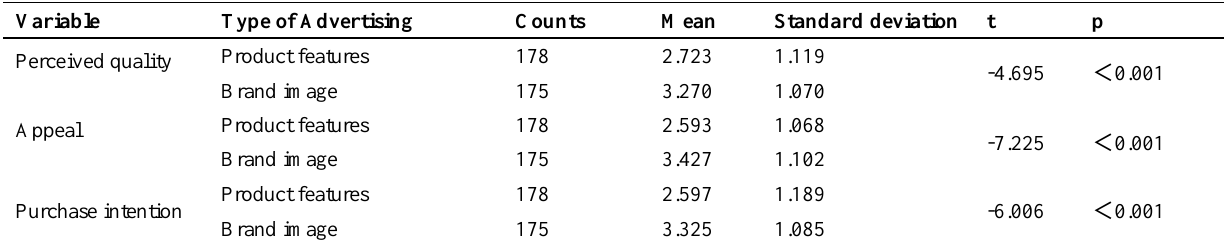
Table 10: The test results for the differences in perceived quality, appeal and purchase intention in cases of different types